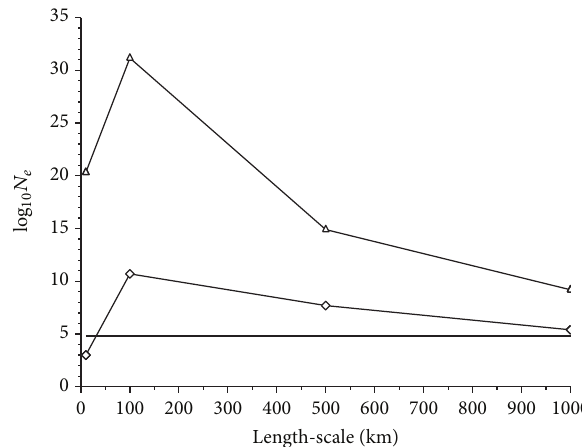
Figure 9: Illustration of the ensemble size deduced from the averaged values 𝑁 − (solid line with diamond marks) and 𝑁 99 % (solid line with triangle marks), for the length-scale values 𝐿 𝑝 ∈ {10, 100, 500, 1000} km, with the dimension set to 𝑛 = 1000 . The solid line with no mark represents the ensemble size 6400 .